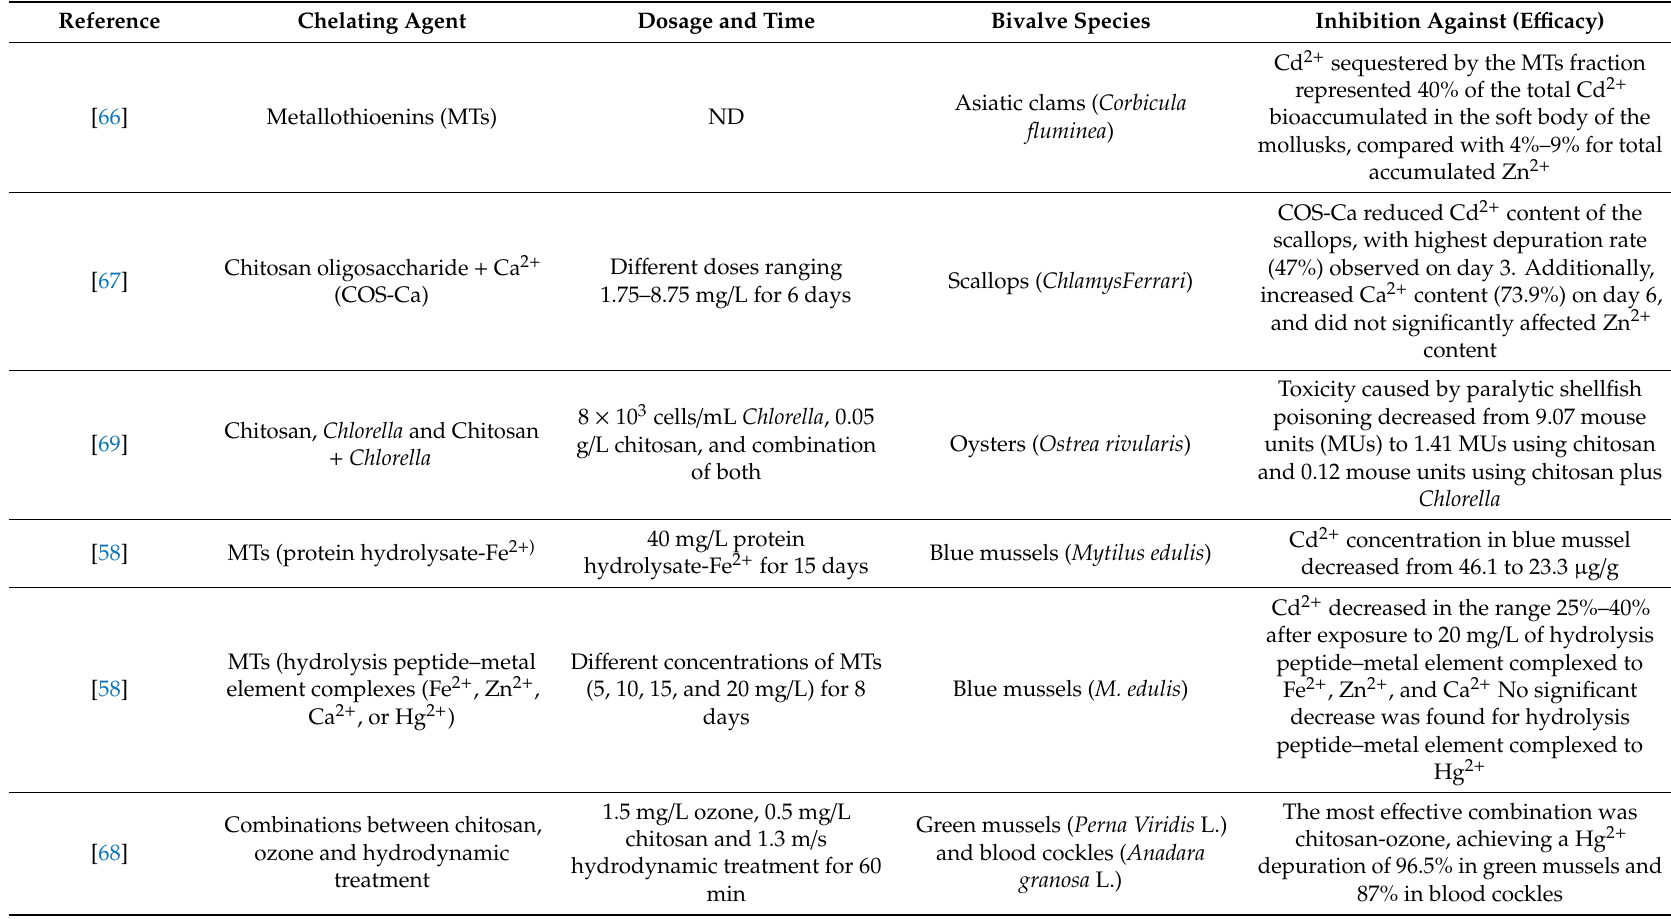
Table 4. Chelating agents used in bivalve chemical hazards’